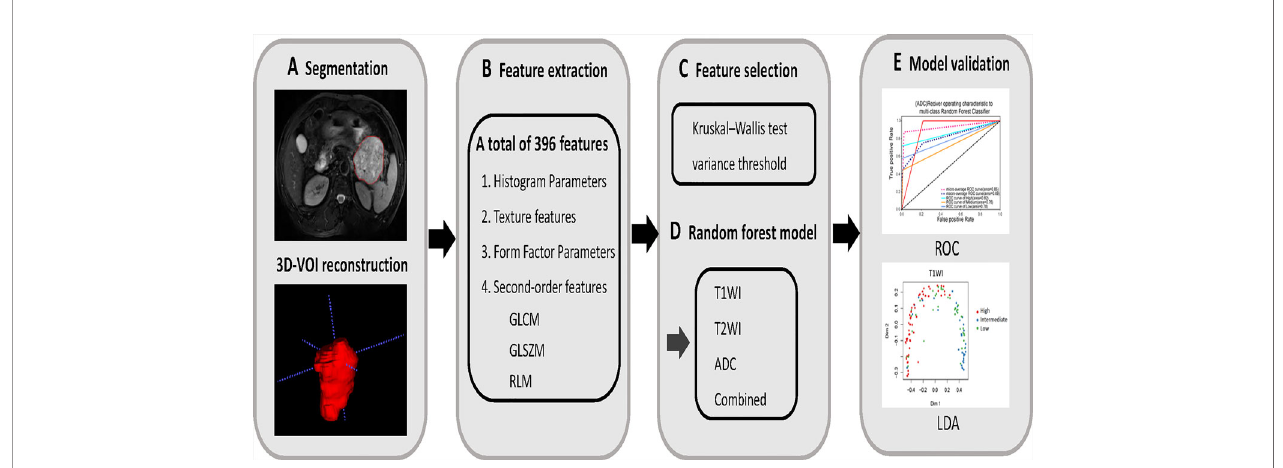
FIGURE 2 | (A) MR images segmentation. The ITK-SNAP software was used to manually outline and segment the tumor region by slices, and then 3D-VOI reconstruction was performed to extract the texture parameters. (B) Texture features extraction. According to the segmentation image, a total of 396 texture parameters of different risk of GISTs were extracted from each set of images. (C) Texture features selection. After the parameters were normalized and dimensionality reduced, the characteristic parameters were selected by Kruskal – Wallis test and variance threshold. (D, E) Model establishment. Using random forest to build multi-sequence MRI model and its diagnostic ef fi cacy was evaluated by ROC and LDA analysis.